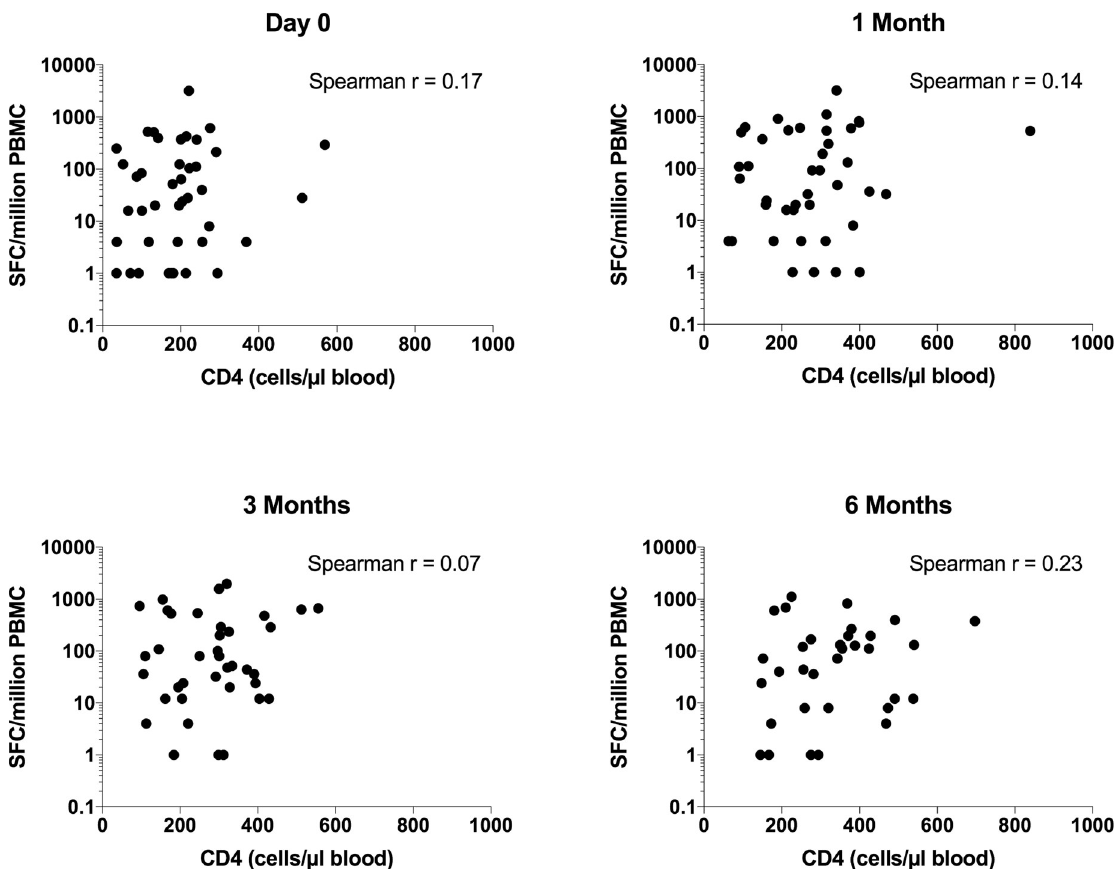
Fig 3. Elispot responses expressed as spot forming cells per million PBMC, related to CD4 counts in cells per microliter blood, at each timepoint. There was no correlation between the ELISpot response and the CD4 counts.